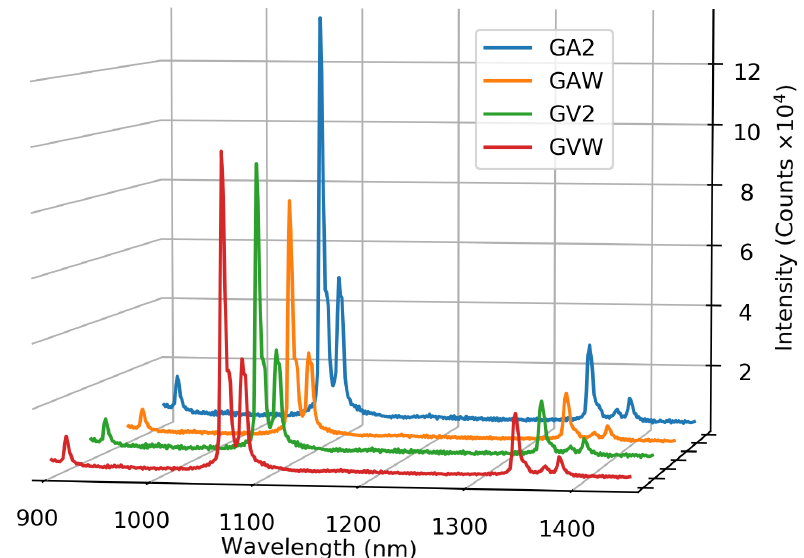
Figure 8. Emission spectrum of the unwashed and washed samples. Excitation with a 500 mW 808 nm